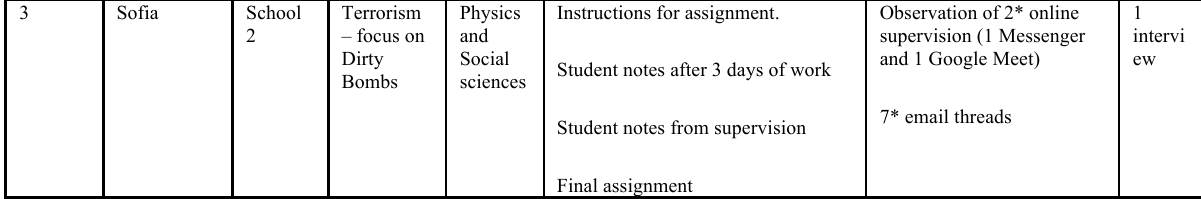
Table 2: Data presenting the qualitative